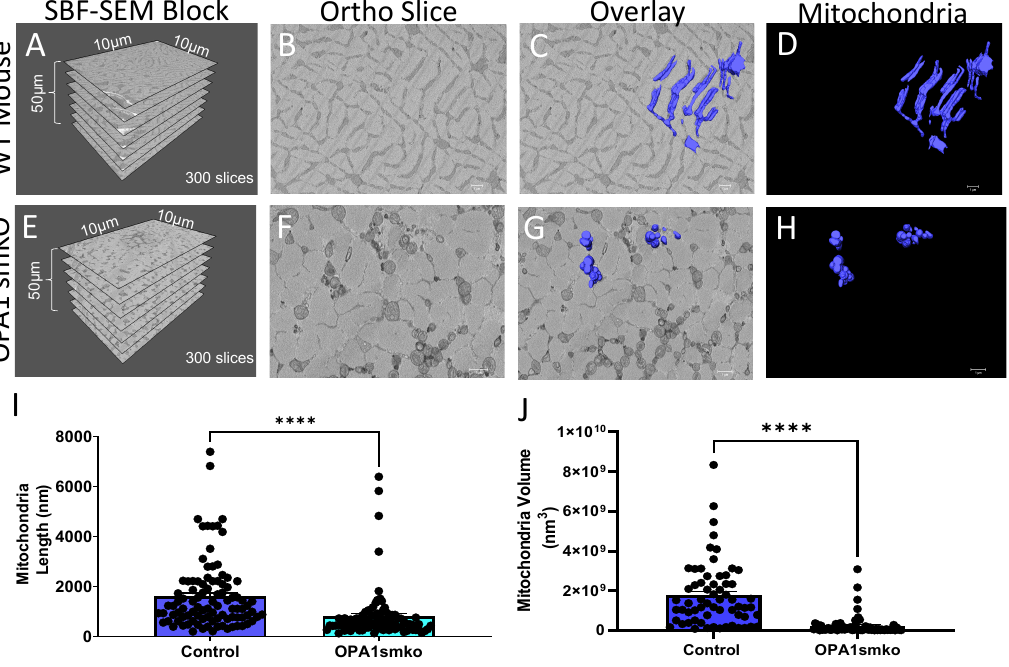
Figure 1. Skeletal muscle specific knockout of OPA1 ( OPA1 smKO) in mouse leads to changes in mitochondrial morphology in the mouse. The 3D distribution of single continuous and stationary mitochondria (blue), reconstructed from serial block facing-scanning electron microscopy (SBF-SEM) image stacks of gastrocnemius muscle from OPA1 smKO mouse ( A – H ). ( A ) The dimensions of the captured tissue in wild type mouse and ( E ) OPA1 smKO, ( B , F ) along with an example ortho slice for each. ( C ) The overlay of the 3D surface rendering of mitochondria in a wild type mouse, on top of a representative ortho slice and ( D ) the 3D surface rendering of mitochondria alone. ( G ) The overlay of the 3D rendering of mitochondria in OPA1 smKO, on top of a representative ortho slice and ( H ) the 3D surface rendering of mitochondria alone. ( I , J ) The 3D mitochondrial length and volume decreased (**** p < 0.001) upon OPA1 smKO. Figure 2 Overlay